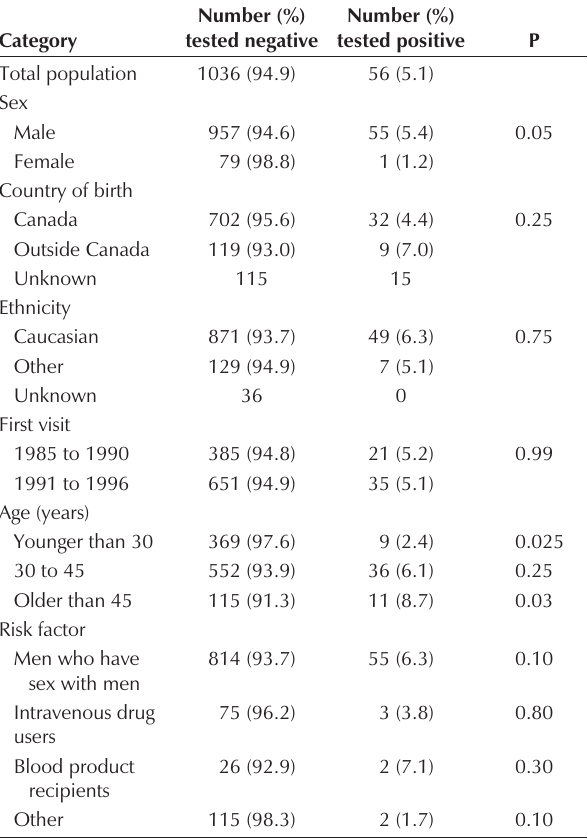
Seroprevalence of syphilis in a regional human immunodefi- ciency virus seropositive population